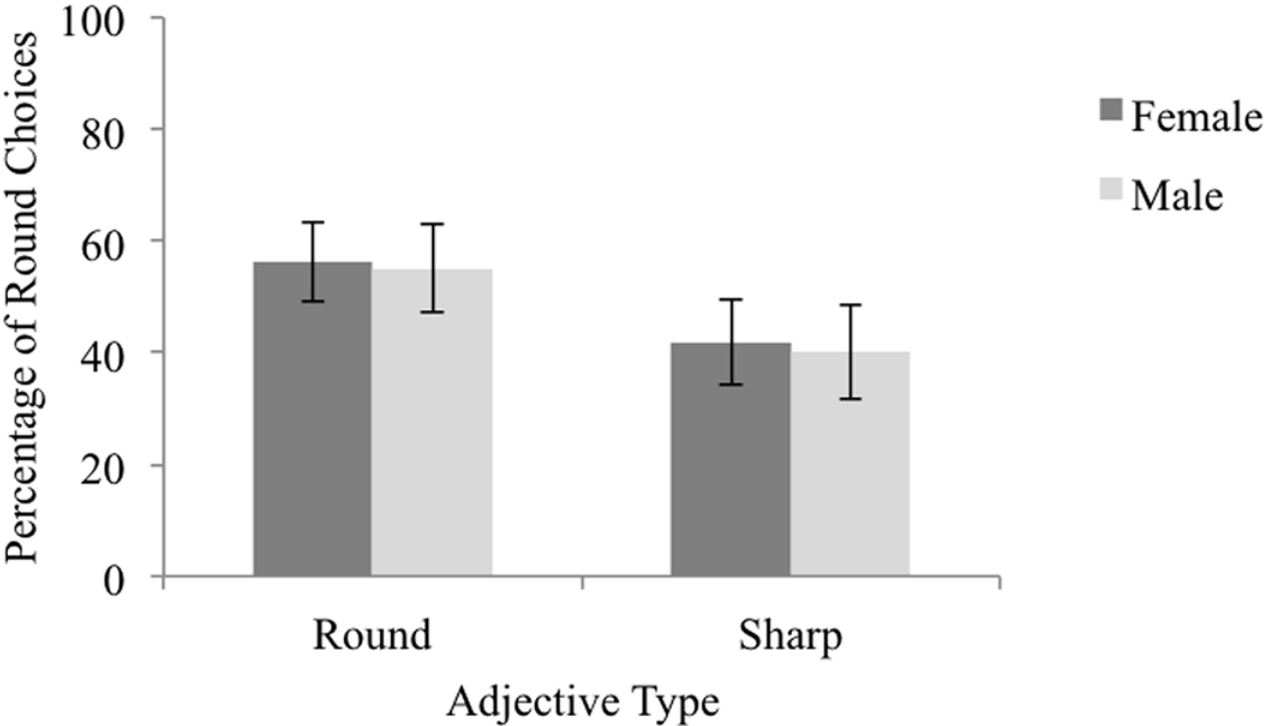
Fig 4. Percentage of Round Choices by Adjective Type and Name Pair Gender in Experiment 2. The percentage of trials on which participants selected the round-sounding name as the best match for a metaphorically-round or a metaphorically-sharp adjective, when the trial included female or male names. Error bars reflect 95% confidence intervals computed using the method outlined by Cousineau [31] to remove between-subject variability.